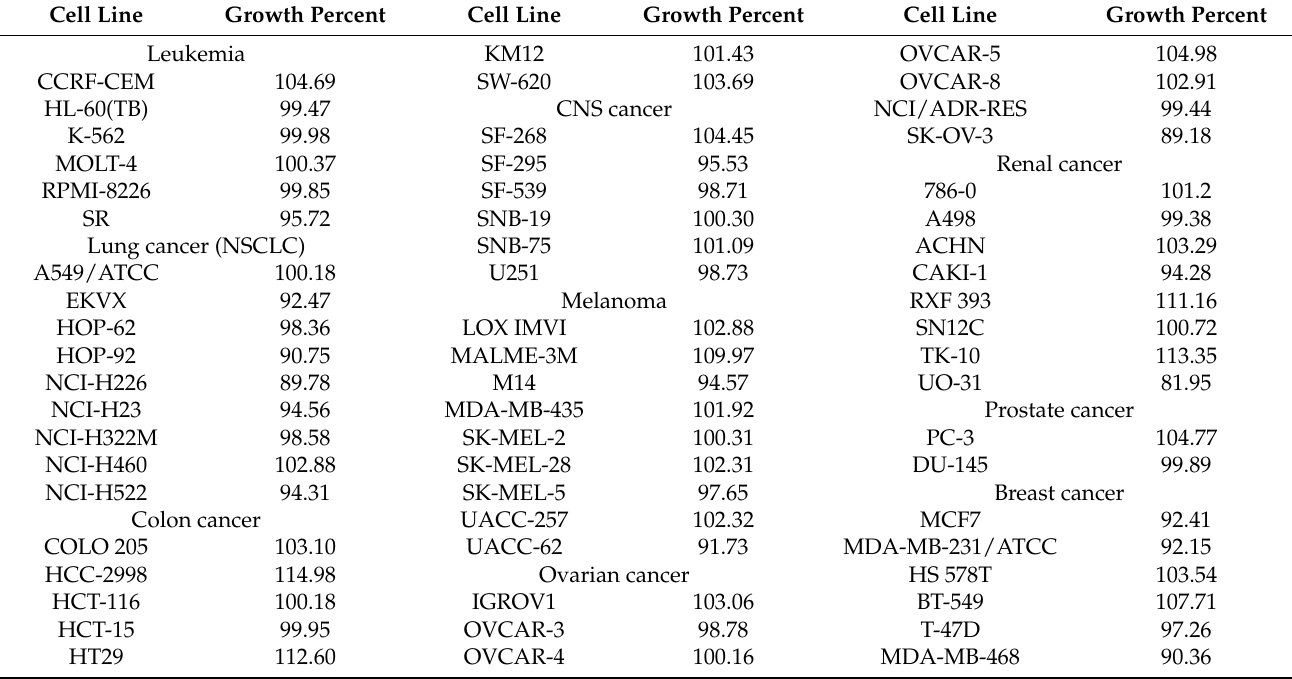
Table 3. The percentage growth of compound 36b in vitro anticancer screening against NCI-subpanel 60 tumor cell lines at a dose of 10 µ M.